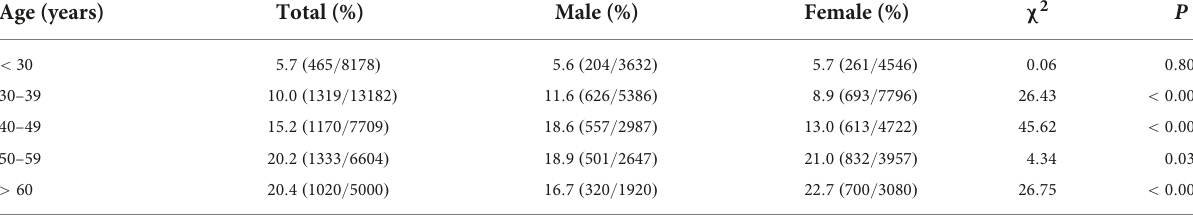
TABLE 3 Comparison of baseline data between non-fatty liver disease (FLD) and FLD subjects in non-obese subjects examined in 2021.